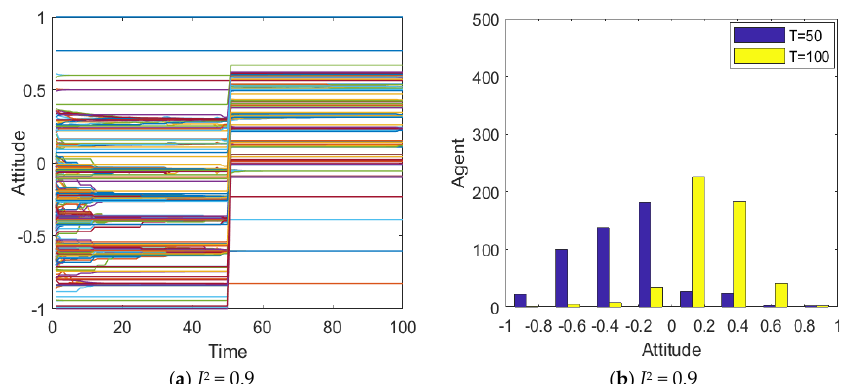
Figure 8. Simulation group opinion evolution chart and opinion distribution histogram based on the literature [14]. ( a ) I 2 = 0.9; ( b ) I 2 =